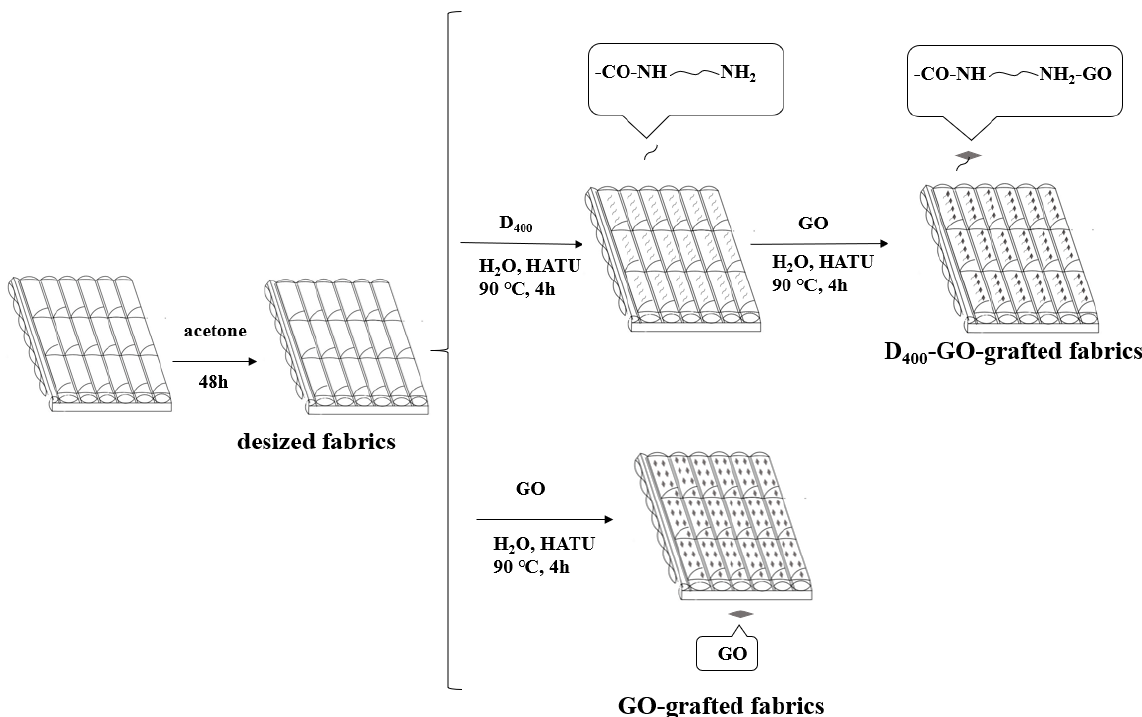
Figure 3: The scheme of grafting process for three kinds of composites: desized fabrics, D400-GO-grafted fabrics, GO-grafted fabrics